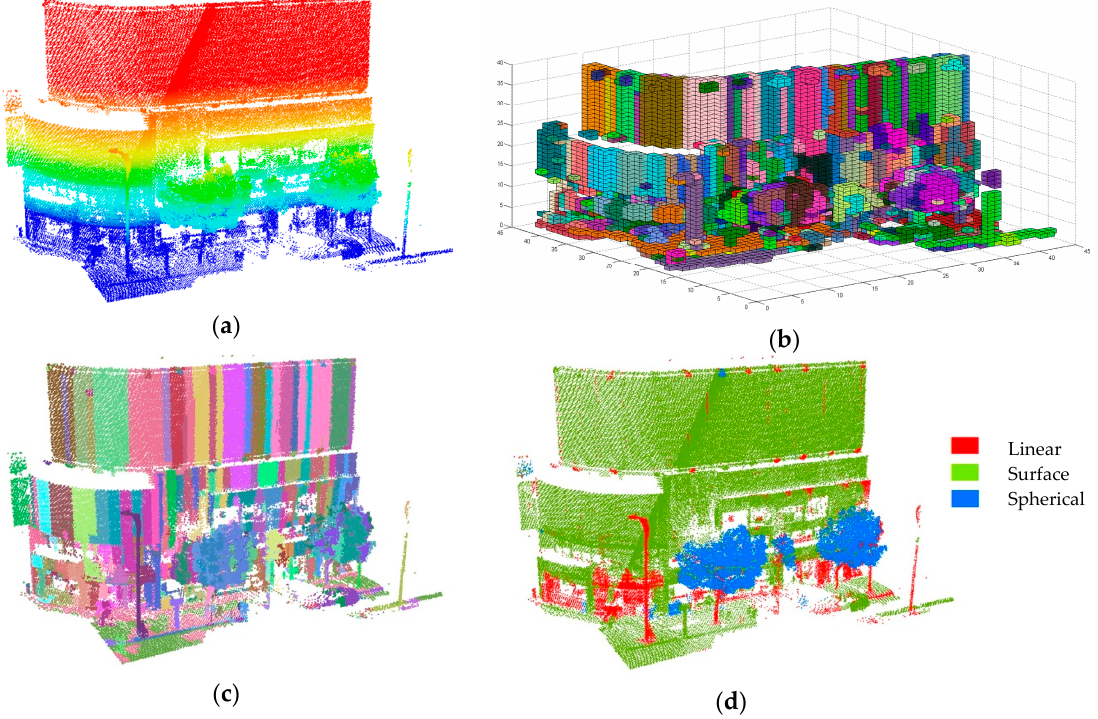
Figure 5. Voxel group-based shape recognition. ( a ) Raw LiDAR point clouds include building facades, street trees, street lamps, cars, and the ground; ( b ) Generated voxel group, voxels of the same color belong to the same voxel group; ( c ) LiDAR points within each voxel group, points of the same color belong to the same voxel group; ( d ) Shape recognition results.